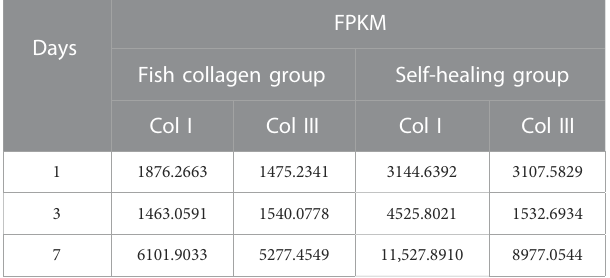
TABLE 6 Average FPKM values of type I and III collagen in wound tissues.